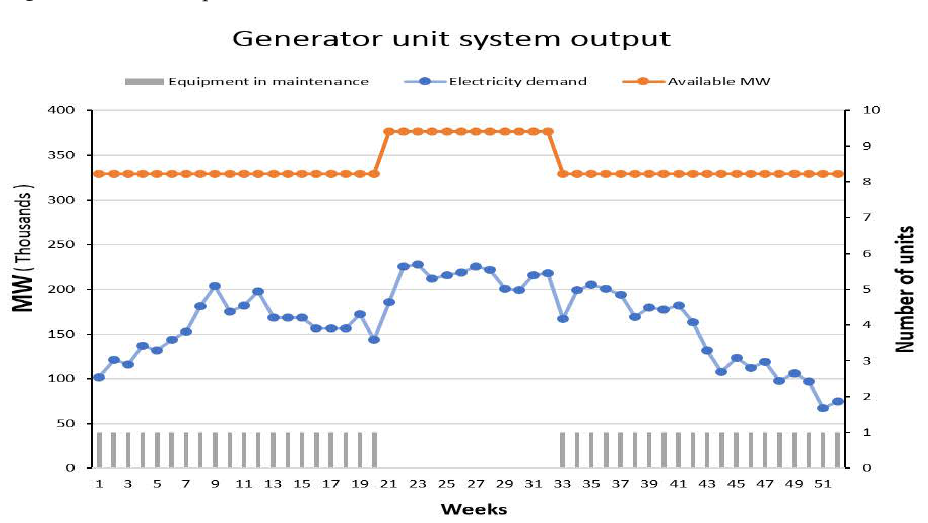
Figure 2. MP water production versus demand.